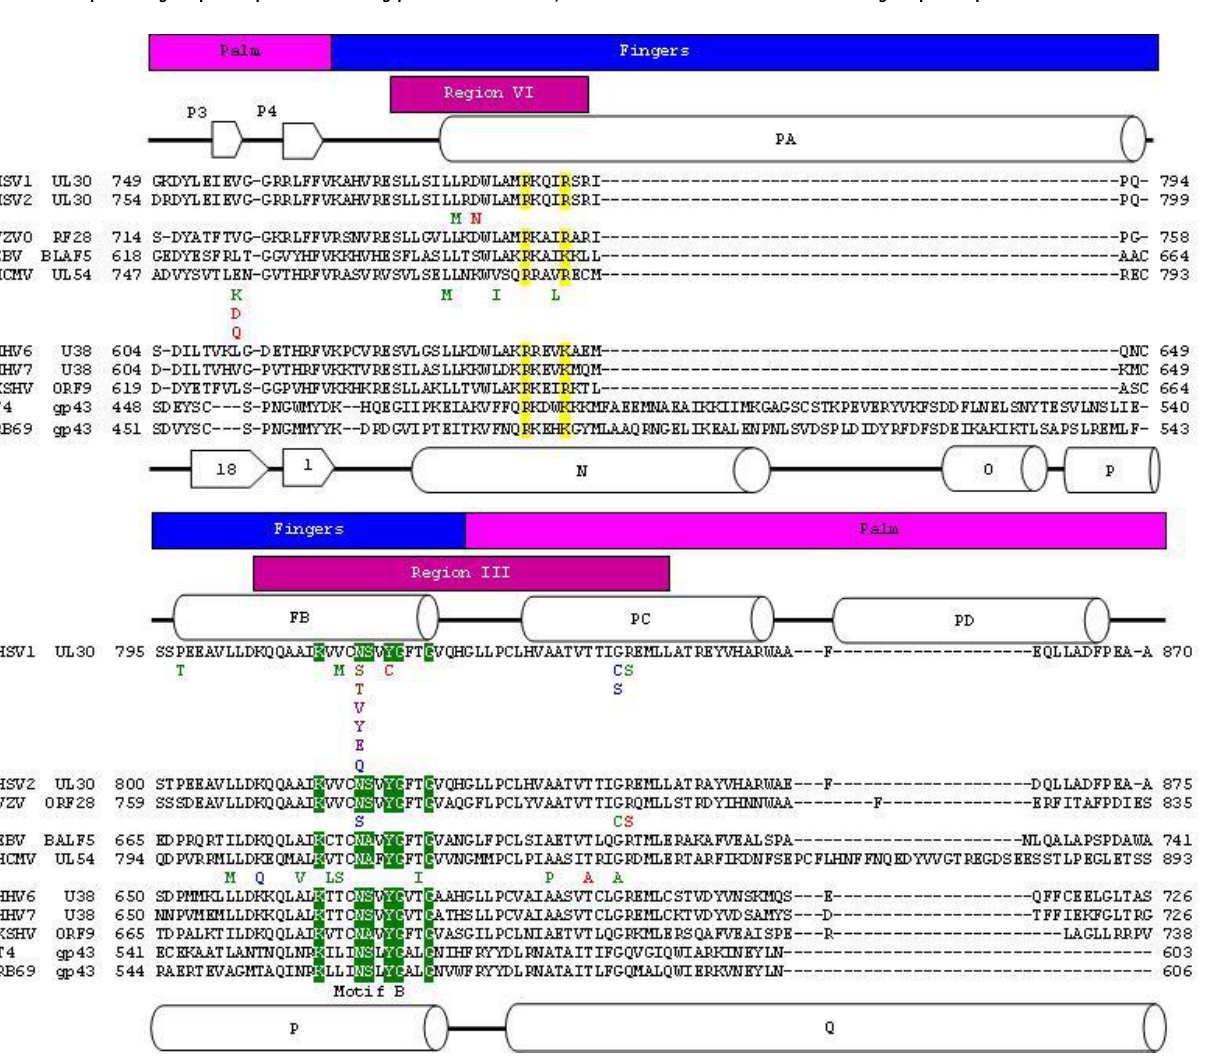
Figure 2. Protein sequence alignment of herpesvirus and bacteriophage polymerase finger domains. Herpesvirus and bacteriophage polymerase were aligned individually using the Muscle algorithm within Geneious [24,25]. The bacteriophage and herpesvirus sequences were then structurally aligned by RAPIDO [26]. Blocks above sequence highlight structural domains of polymerase. The palm domain is in pink. The fingers domain is in blue. The known conserved regions are shown in magenta blocks above sequence [27–31]. Secondary structural elements of HSV1 UL30 are indicated and are number according to Liu et al. (2006). Secondary structural elements of RB69 gp43 are indicated and are numbered according to Wang et al. (1997). Structural motifs are highlighted in sequence. N helix residues are in yellow. Motif B is in green. Mutations that have been associated with resistance to current anti-herpetic drugs are shown below the corresponding residue [32,33]. Resistance mutations are colored using the following scheme: Red: Pyrophosphate R (Resistant), Blue: Nucleotide R , Green: Pyrophosphate R and Nucleotide R . Purple: Pyrophosphate HS (Hypersensitive), Brown: Nucleotide R but Pyrophosphate HS